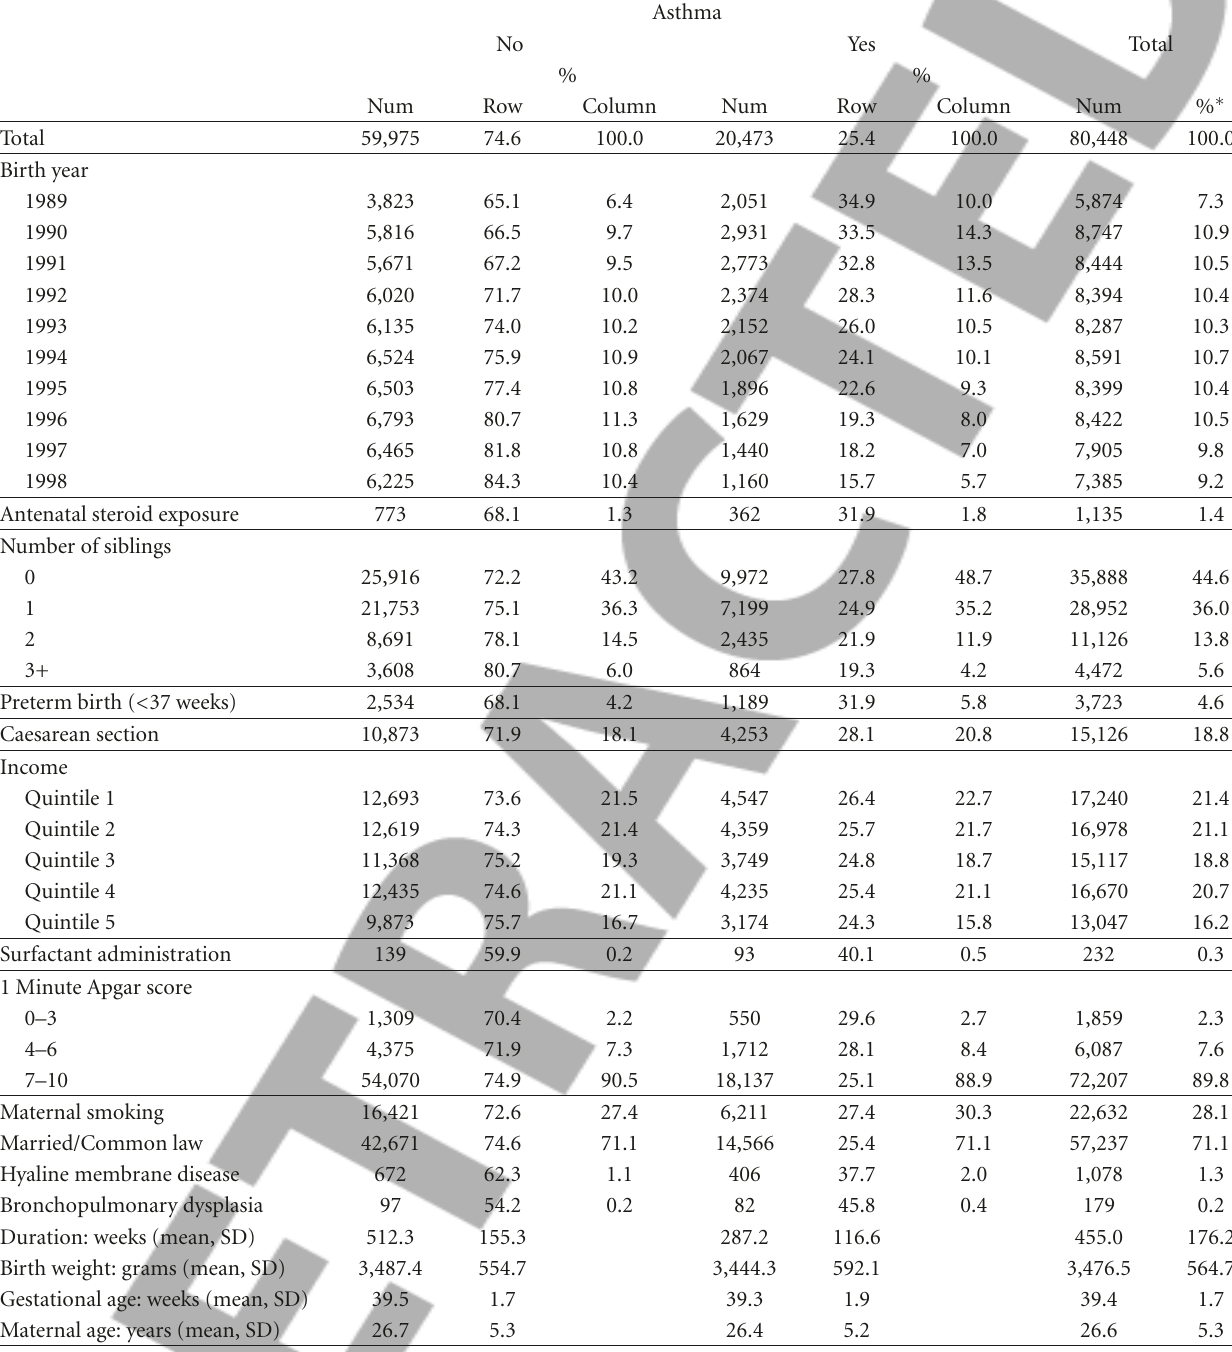
Table 1: Descriptive characteristics of the study sample by asthma